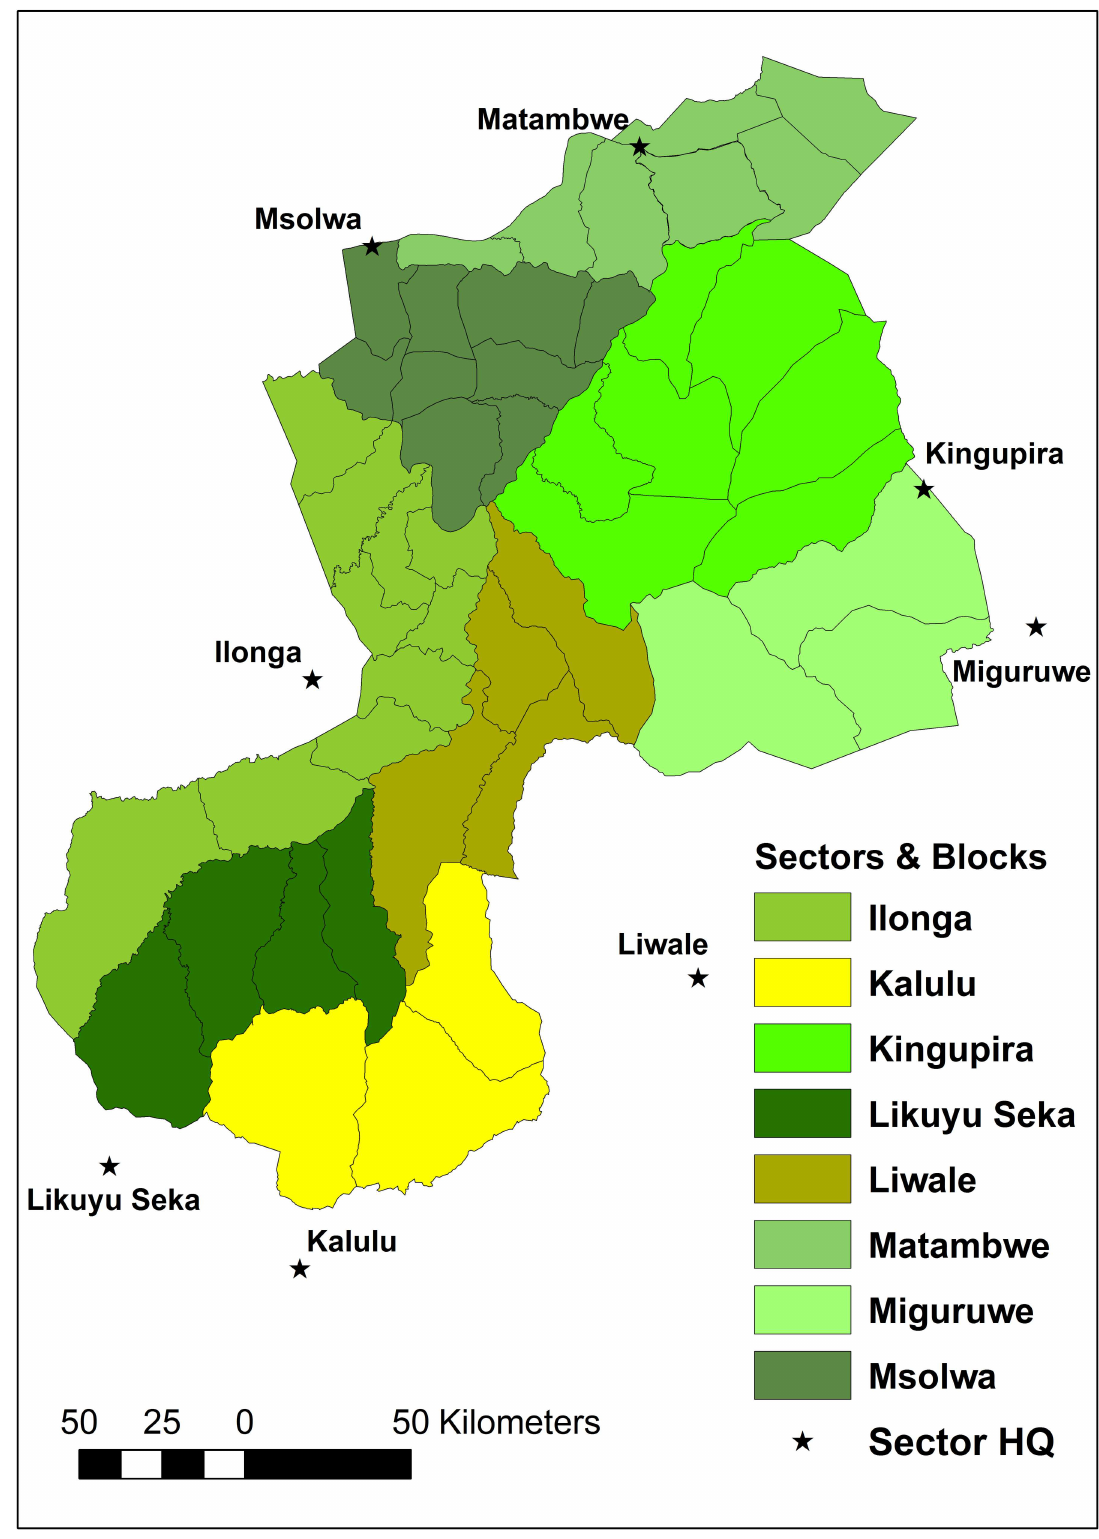
Fig 2. Map of sectors and blocks of SelousGame Reserve.